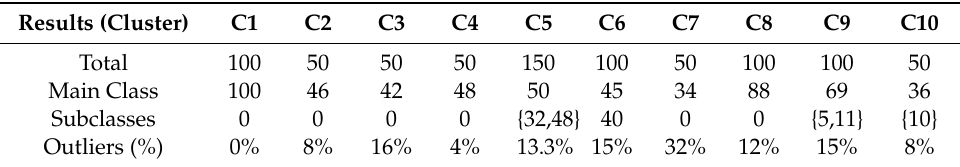
Table 2. User fine-grained classification details of each cluster.